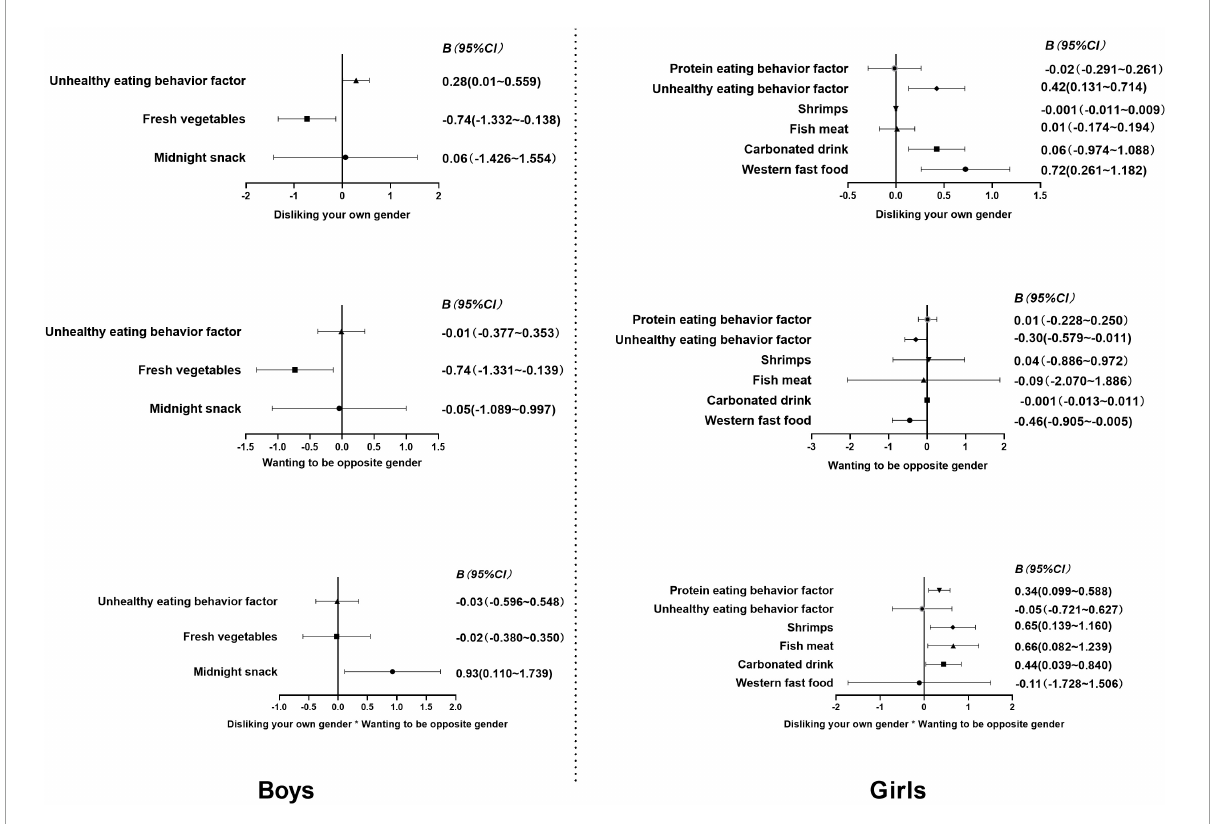
FIGURE2 95% CI of association coefficients between eating behaviors and negative gender